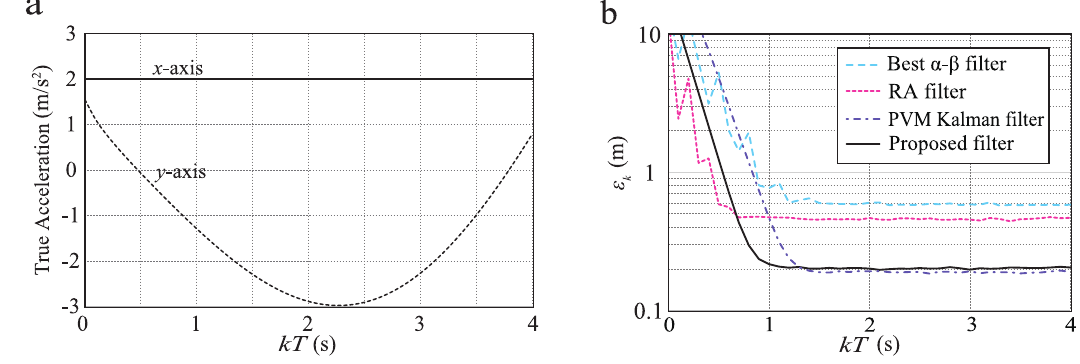
Figure 5. Simulation assuming a high-maneuvering target: ( a ) true acceleration; ( b )